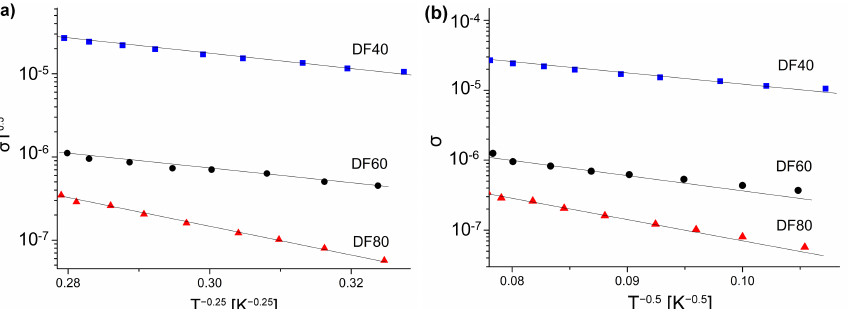
Figure 7. The plot of Mott’s ( a ) and Efros-Shklovskii ( b ) relations for low temperature region. Symbols are experimental data and the straight lines represent the